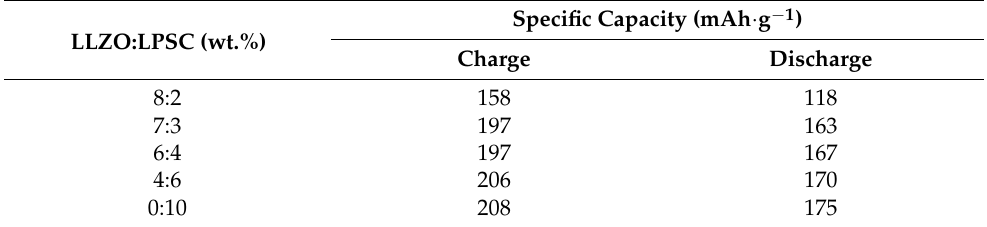
Table 2. Specific capacities of ASSCs with composite electrolytes with different LLZO:LPSC